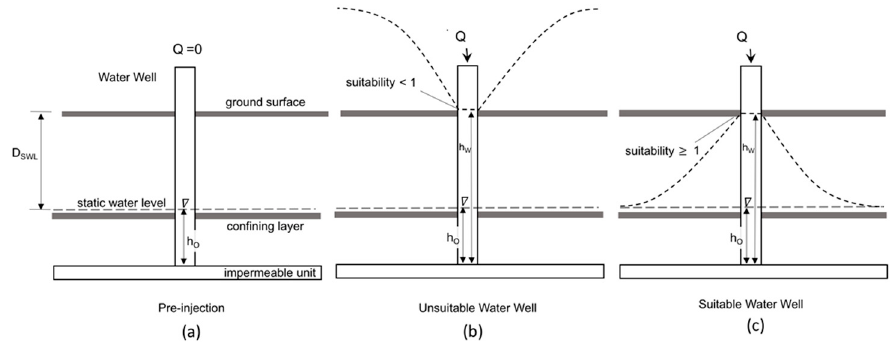
Figure 6. Illustration of hydrogeologic properties used to represent the water well suitability equation. ( a ) is a pre-injection scenario for a representative water well. D SWL is the depth to static water level below ground surface, h o is the initial hydraulic head, h w is the hydraulic head undergoing injection, and Q is injection of water. Scenario ( b ) is unsuitable for ASR when a water well suitability of less than 1 is calculated, as the potentiometric surface has exceeded the ground surface. Scenario ( c ) is a suitable water well, since water well suitability is calculated at greater than or equal to 1.